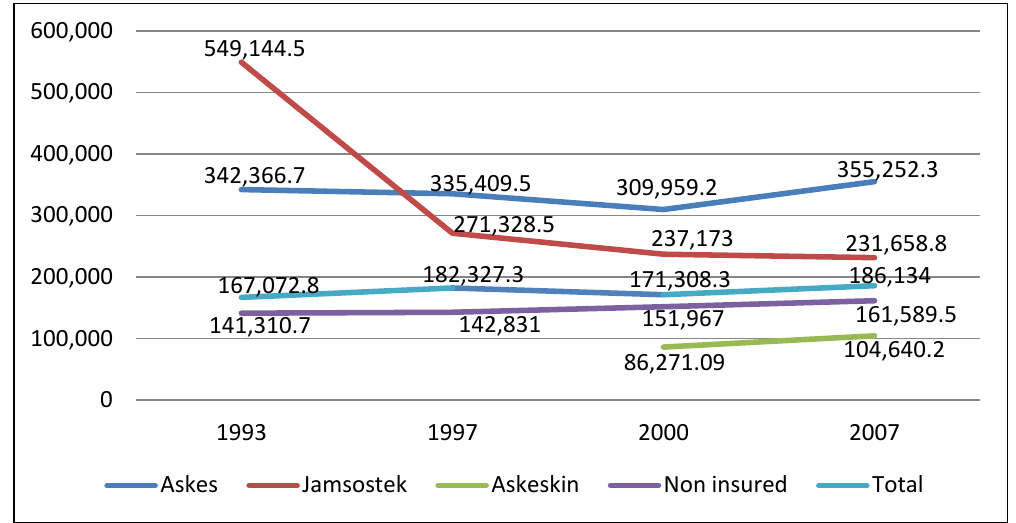
Figure 1. The distribution of mean out-of-pocket expenditures across year in Indonesia Rupiah (IDR) (1€ = 12,421.89 IDR).